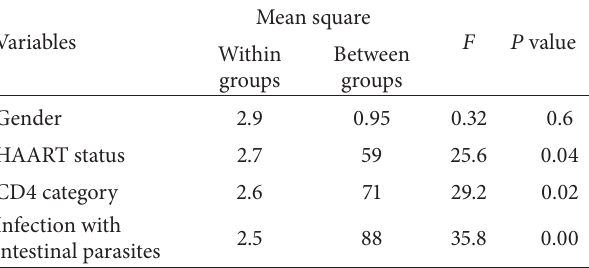
Table 4: One-way ANOVA analysis of hemoglobin concentration among pediatric HIV/AIDS patients attending Zewditu Memorial Hospital from August 5, 2013, to November 25, 2013, Addis Ababa,